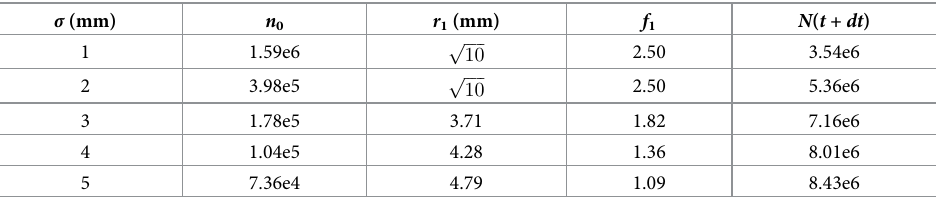
Optimal one-step profile for one fraction of radiation with exponential growth and death. n 0 and σ are the magnitude and standard deviation of the initial Gaussian tumour cell density, which starts with 10 7 total cells. r 1 and f 1 are the radius and strength of the step in the cytotoxic radiation profile. N ( t + dt ) is the final tumour cell number at the end of